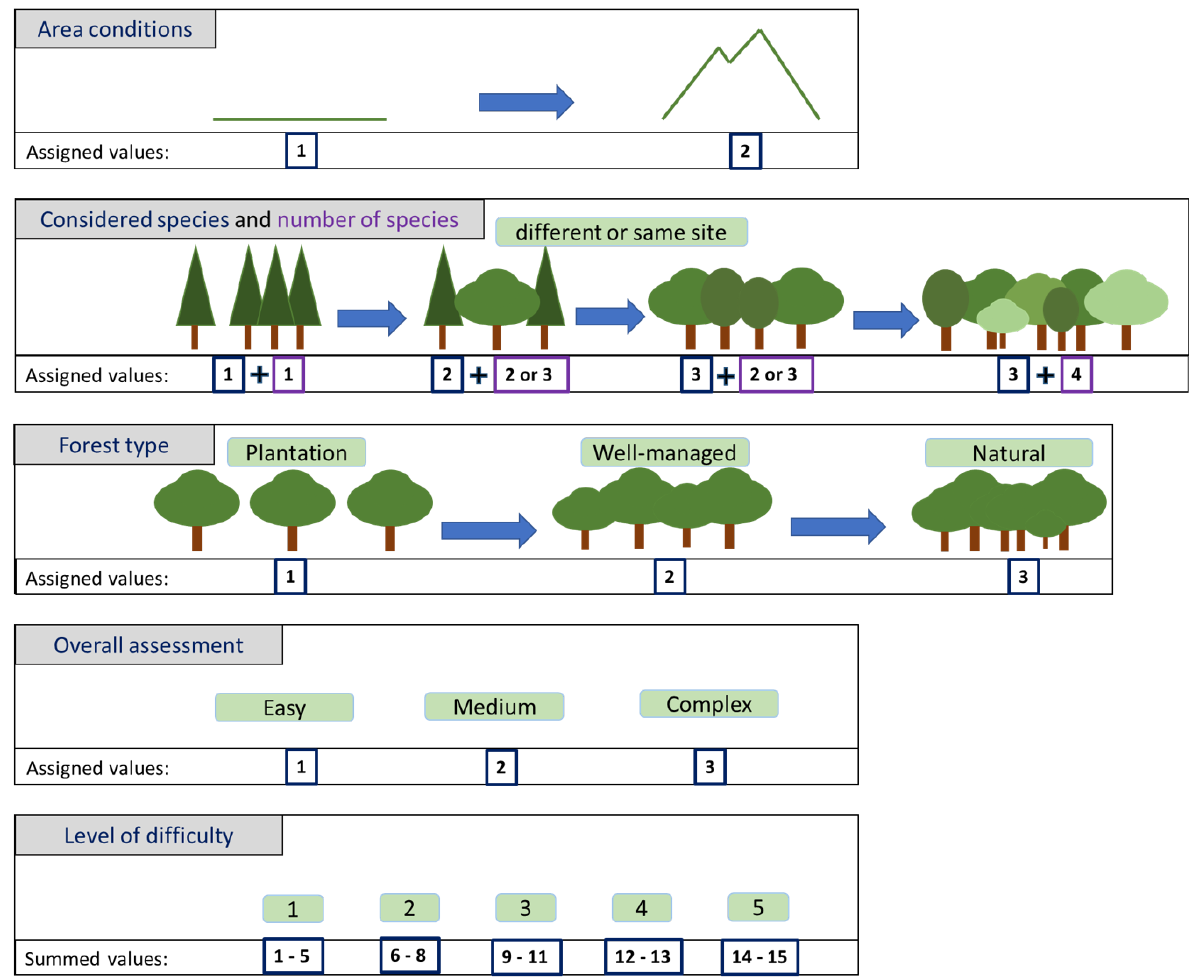
Figure 2. Evaluation system for the level of difficulty from the forestry point of